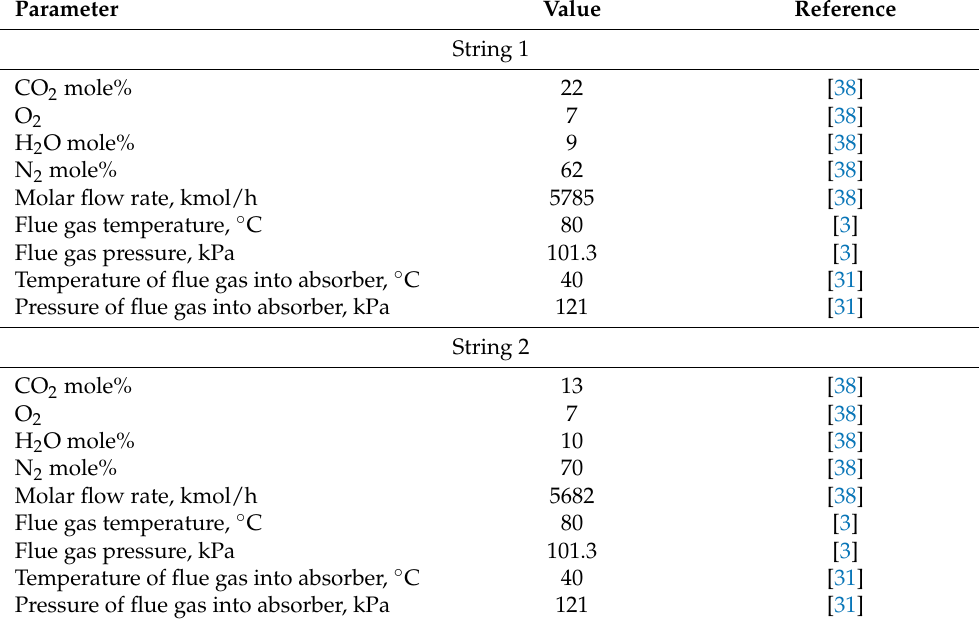
Table 2. The cement plant flue gas